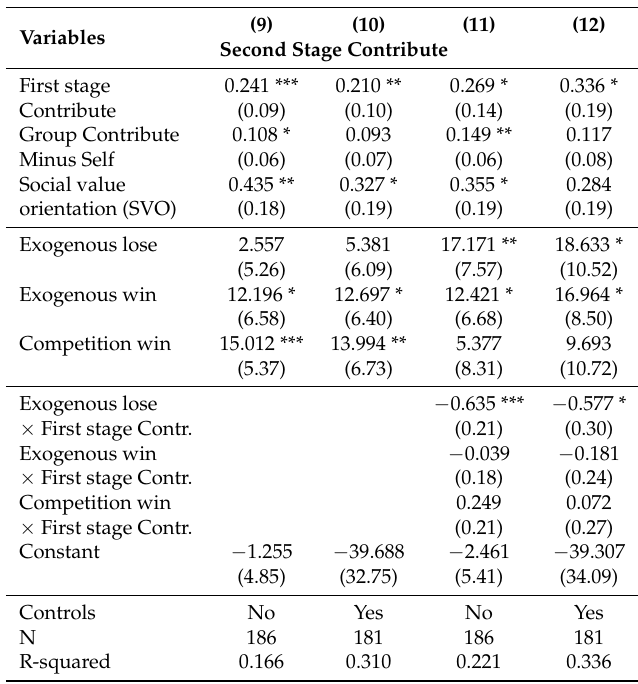
Table A2. Determinants of stage 2 contribution—OLS Regression.